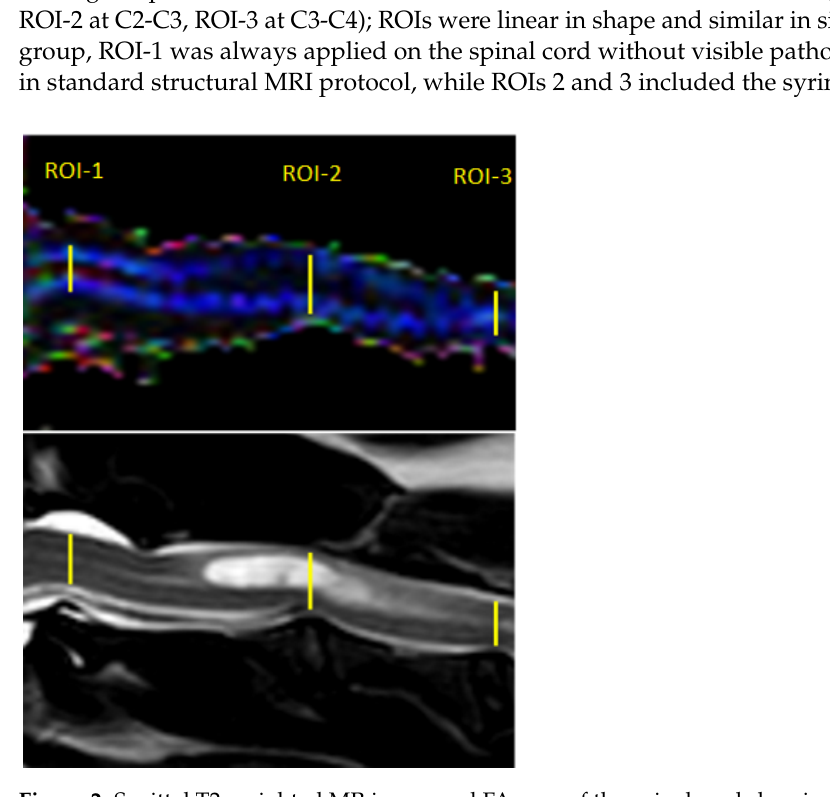
Figure 2. Sagittal T2 ‐ weighted MR image and FA map of the spinal cord showing ROIs placement within the spinal cord of the SM dog.